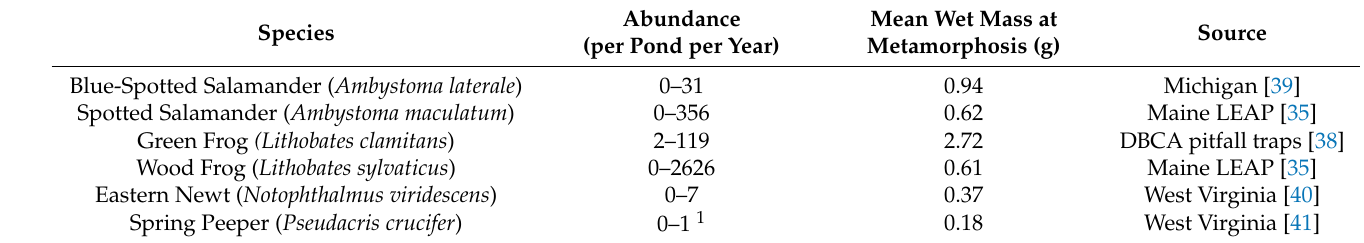
Table 1. Recently metamorphosed species produced by Maine ponds, range of abundance per pond per year, mean wet mass at metamorphosis used in biomass estimates, and the source for individual mass estimates.